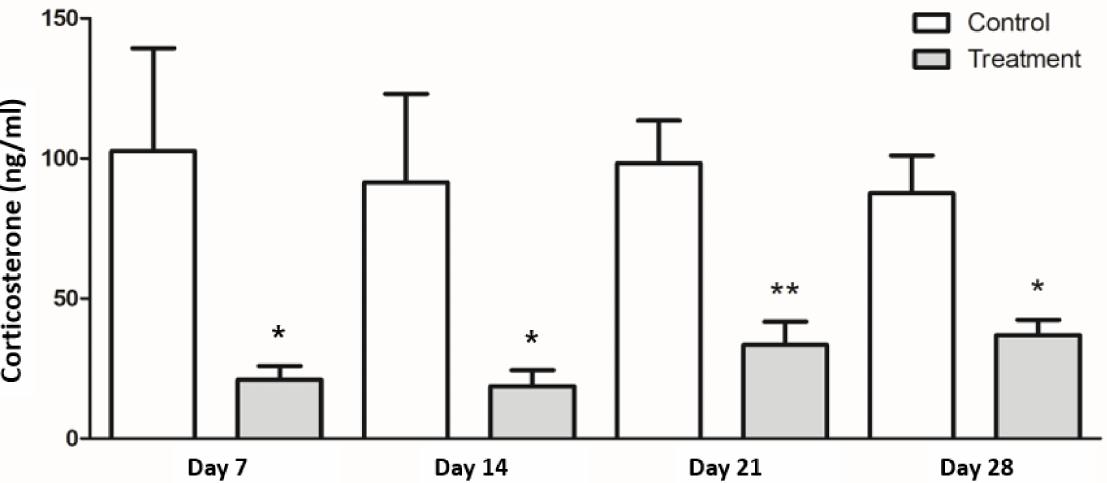
Figure 4. Serum corticosterone levels. Serum corticosterone was measured from blood collected immediately after the restraint period ended at the indicated day. Treatment group (gray bar) showed lower level of serum corticosterone than control group (white bar). Results are expressed as the mean ± SEM ( n = 7/group). * Indicates significant differences by unpaired t -test; * p < 0.05, ** p < 0.01.